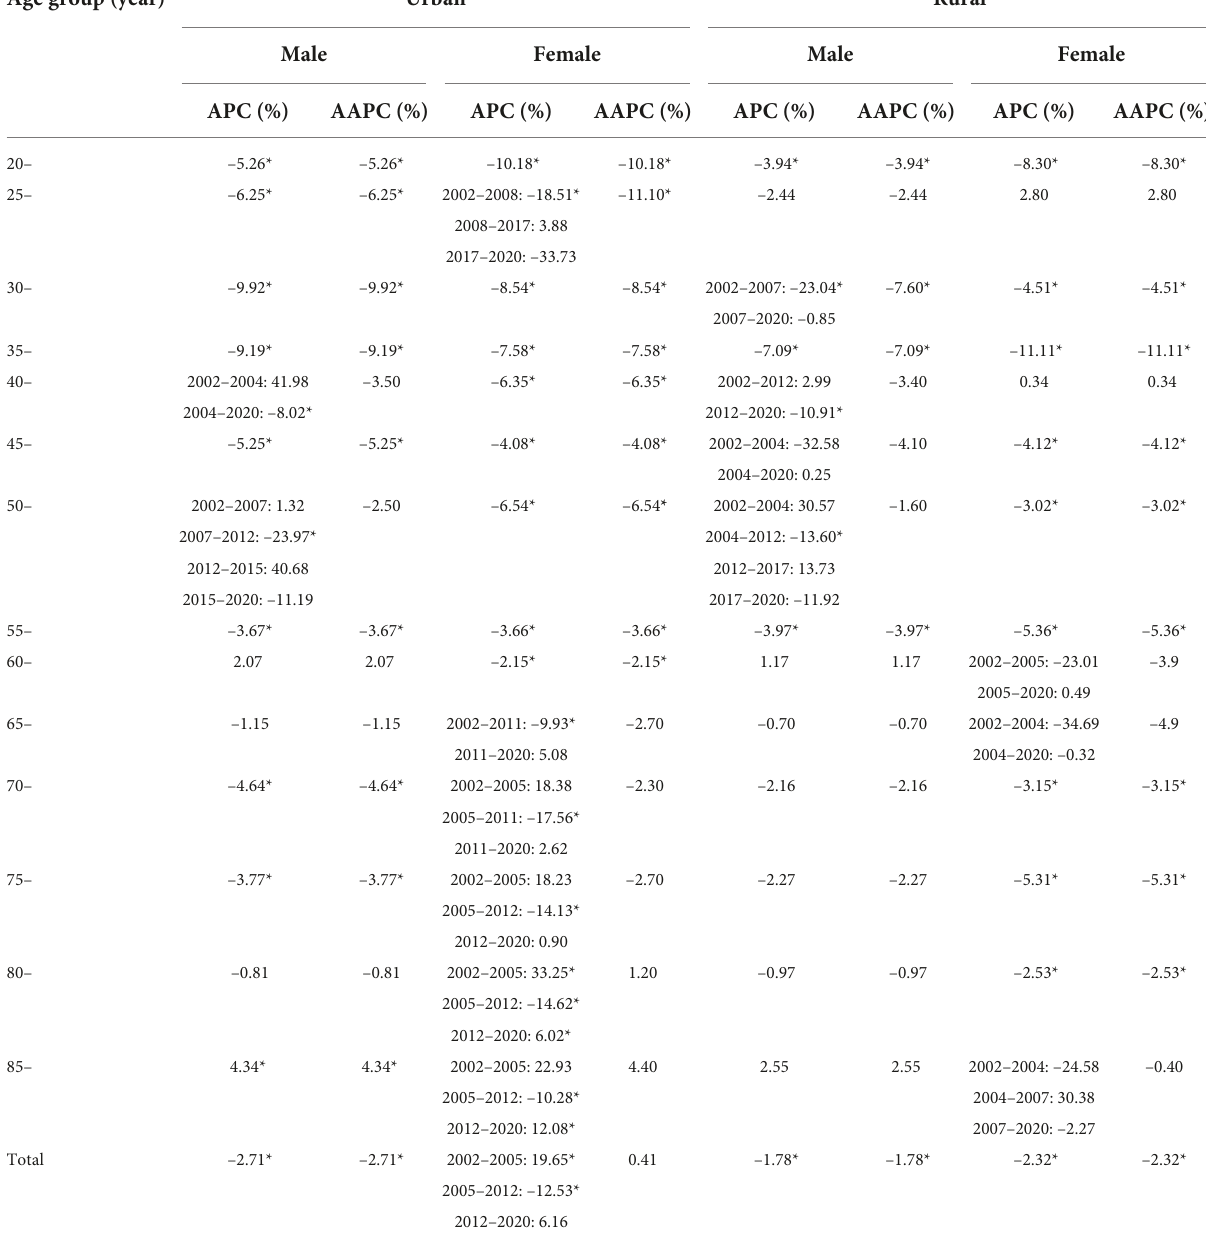
TABLE 2 Annual changes in mortality rates of mental disorder for Chinese residents from 2002 to